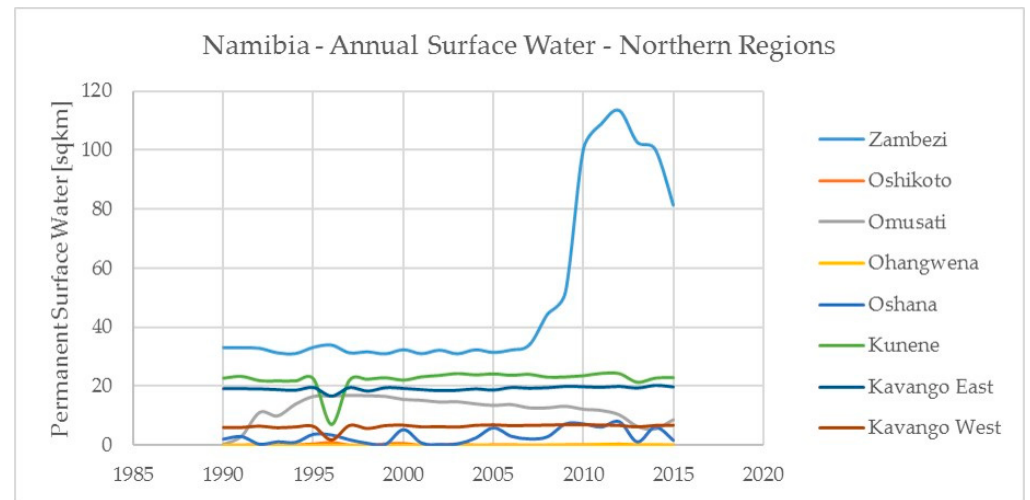
Figure 7. Annual Permanent Surface Water—Northern Regions.